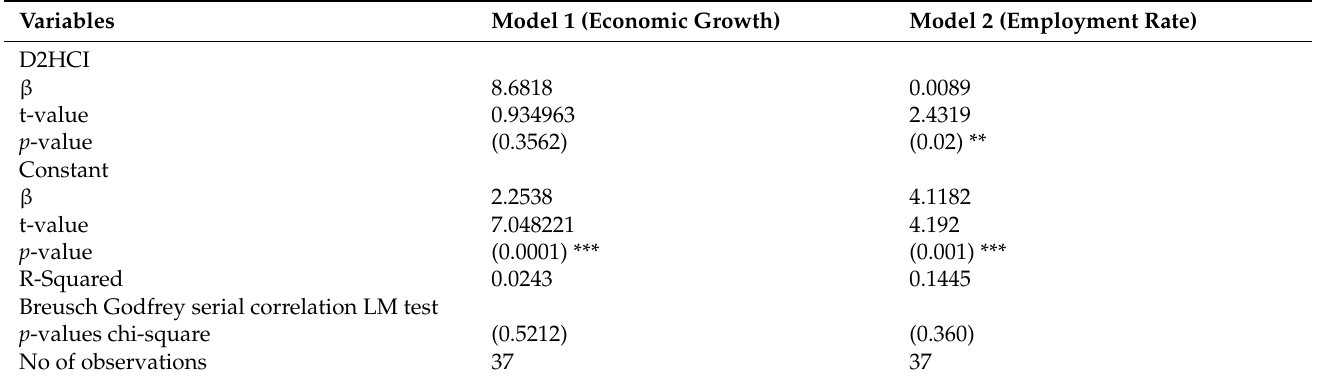
Table 3. Results for simple linear regression